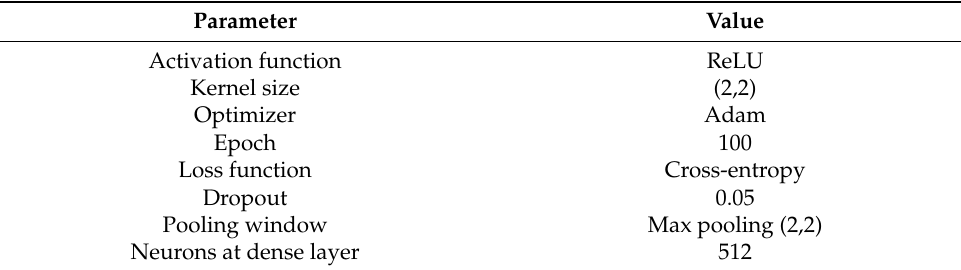
Figure 2. CNN structure [29]. Table 3. Parameters of the